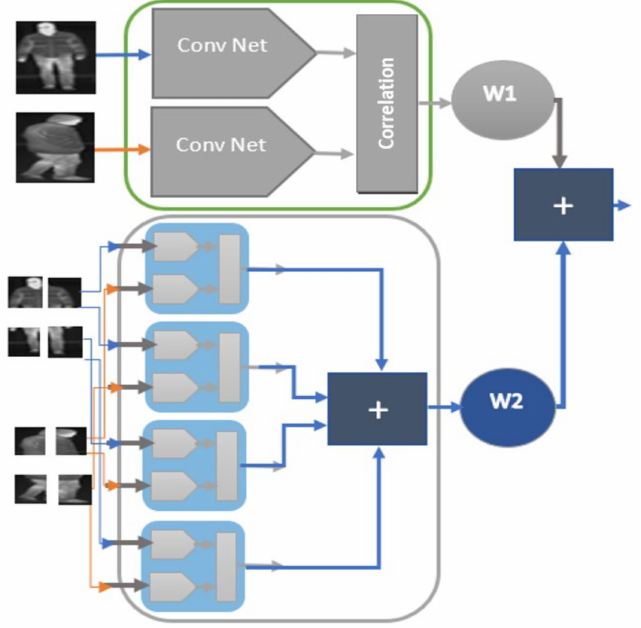
Figure 2. Architecture of the proposed data driven cost based on a family of Siamese Networks. These networks work on the whole image and on parts of it, improving the robustness of the TIR